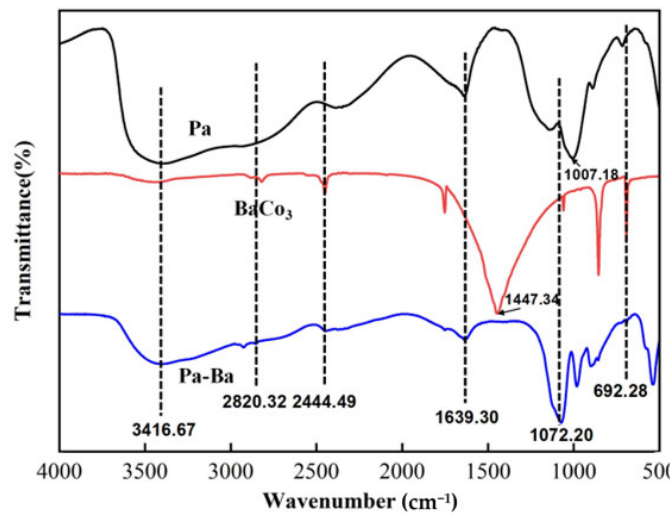
Figure 1. FTIR spectra of Pa, BaCO 3 , and Pa-Ba.